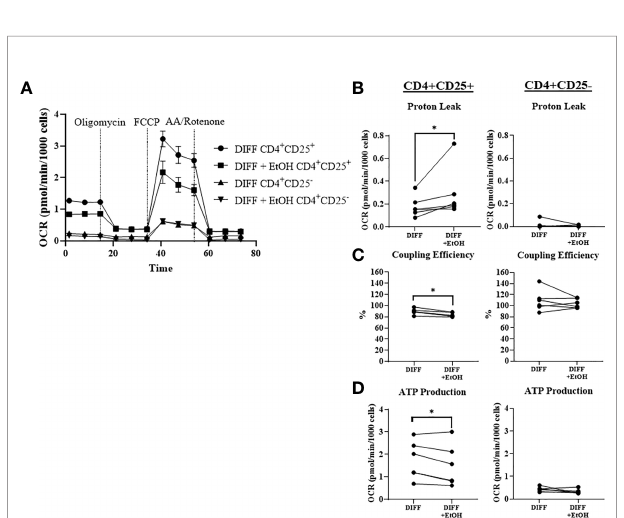
FIGURE 6 | Mitochondrial function within CD4 + CD25 + (enriched Treg) and CD4 + CD25 - (enriched Th1) CD4 + subsets. (A) Enriched Treg and Th1 cells from DIFF and DIFF + EtOH groups were analyzed using Mitostress test. (B) Ethanol increased proton leak in enriched Treg, but not enriched Th1 cells. (C) Ethanol decreased coupling ef fi ciency in enriched Treg, but not enriched Th1. (D) Ethanol decreased ATP production in enriched Treg, but not enriched Th1 cells. OCR= oxygen consumption rate. FCCP = Carbonyl cyanide-p- tri fl uoromethoxyphenylhydrazone. AA = Antimycin (A) DIFF = differentiated cells and no ethanol treatment, and DIFF + EtOH = differentiated and ethanol-treated. Data represents CD4 + T cells from 6 donors with lines connecting values of same donors. Signi fi cance differences (p ≤ 0.05) were determined by paired T- tests and Wilcoxin test (Treg – proton leak). *p ≤ 0.05.